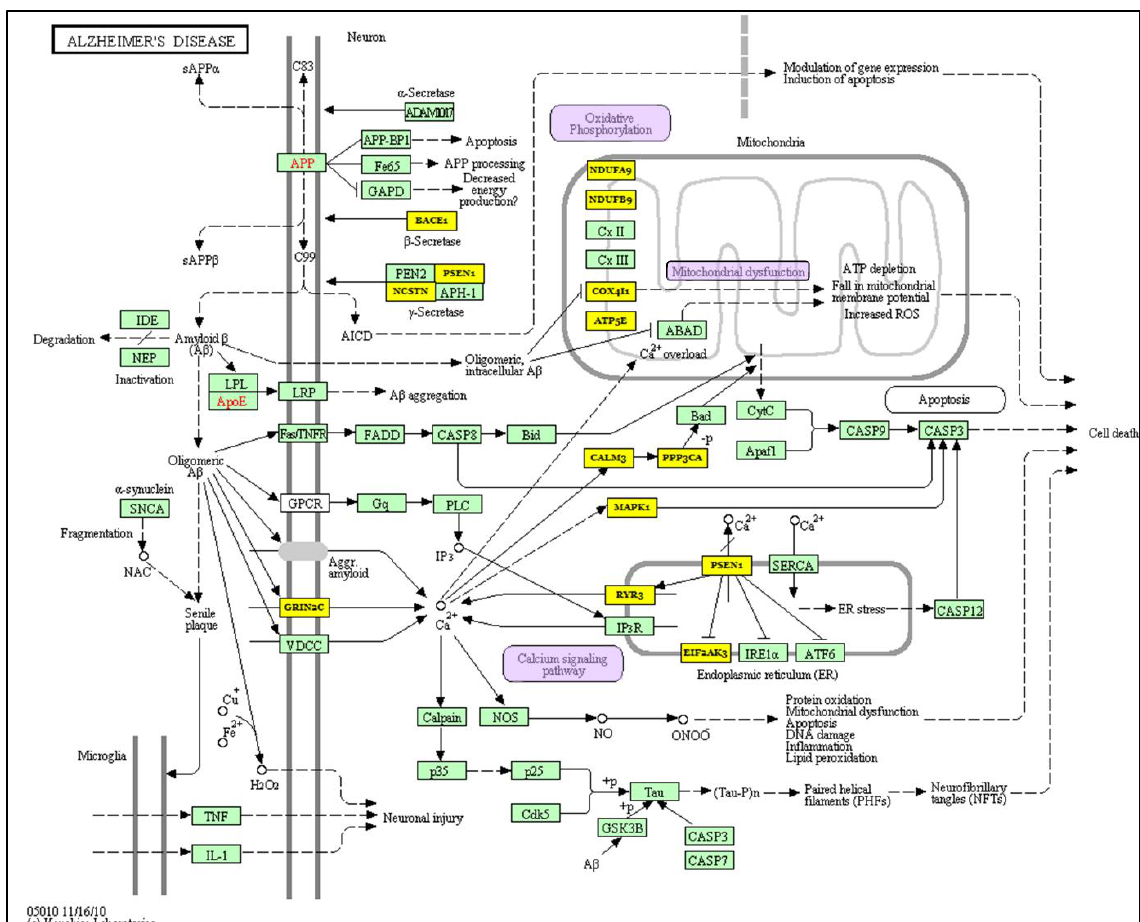
Figure 7. KEGG Alzheimer’s disease pathway (hsa05010): The selected target genes are highlighted by yellow boxes. The genes involved in oxidative phosphorylation, mitochondrial dysfunction, and the calcium signalling pathways are indicated by purple boxes. The gene GRIN2B was not identified as being involved in this pathway and is therefore excluded from the figure.